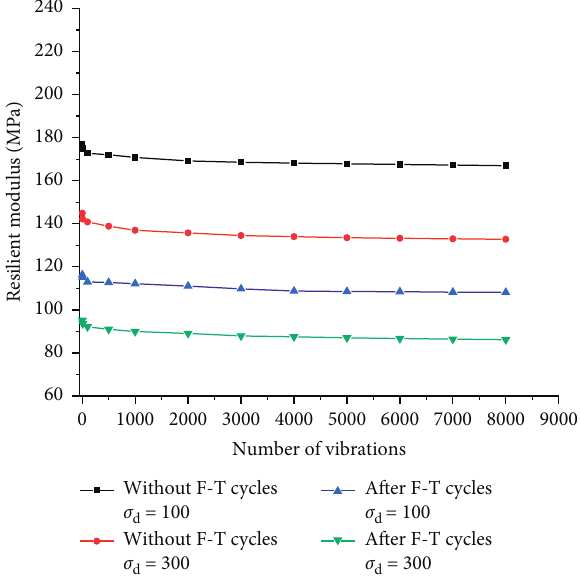
Figure 8: Resilient modulus of SOF during large times of